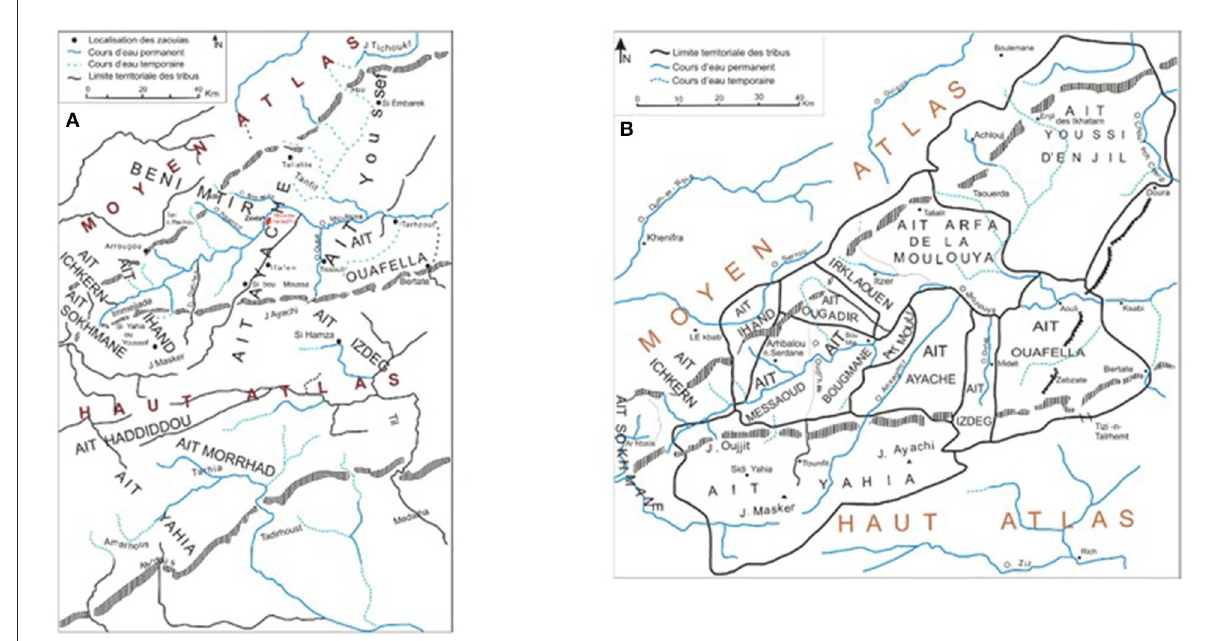
FIGURE5 (A) Human groups on the Upper Moulouya at the beginning of the 19th century (adapted from B.E.S.M, 1956 by authors). (B) Geographic location of the tribes living in the Upper Moulouya in 1950 (adapted from B.E.S.M, 1956 by